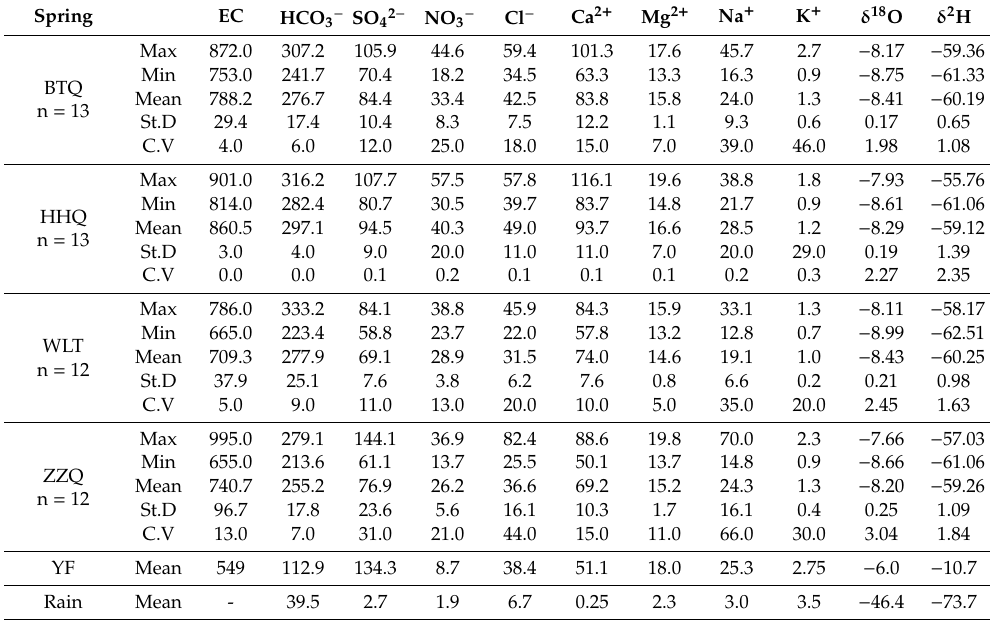
Table 1. The statistic values of major ion components in spring water, river water, and rain water.